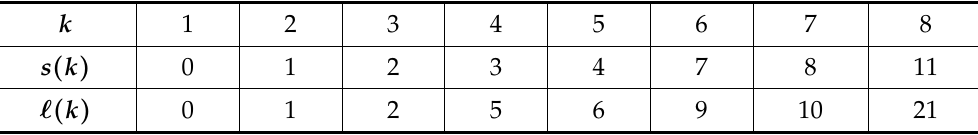
Table 2. The initial values for the sequences s ( k ) and (cid:96) ( k ) . k